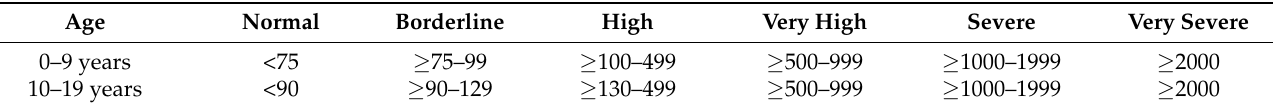
Table 6. Triglycerides levels stratification in pediatric